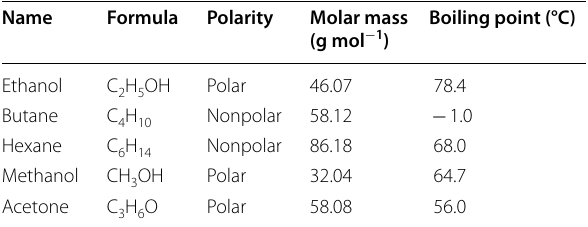
Table 2 Popular low molecular mass organic